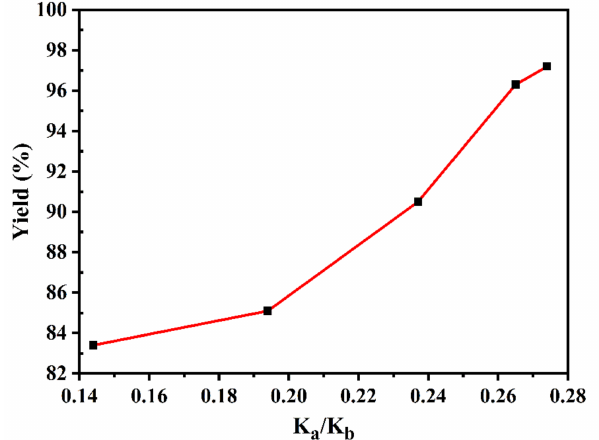
Figure 8. The relationship between the values of K a / K b and the PC yield. Reaction condition: n (PG) / n (urea) = 3; mass fraction of the catalyst = 1%; reaction time = 5 h; reaction temperature = 433